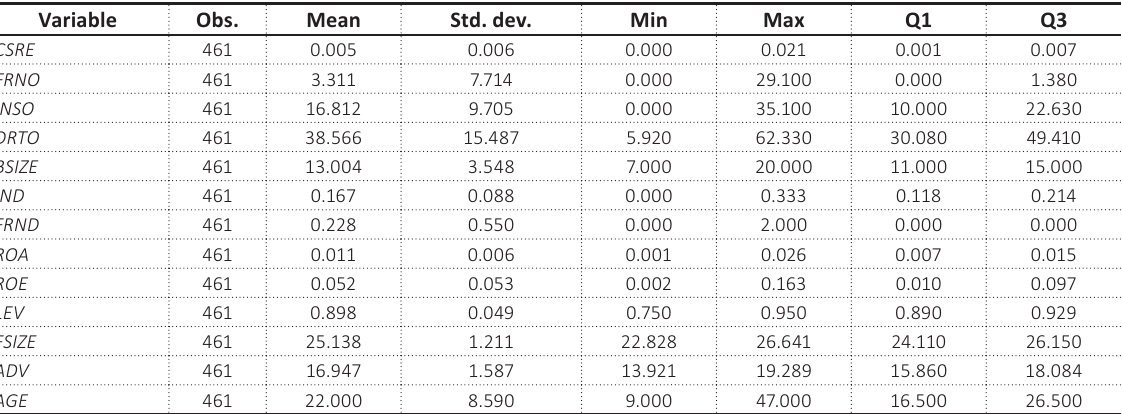
Table 3. Descriptive